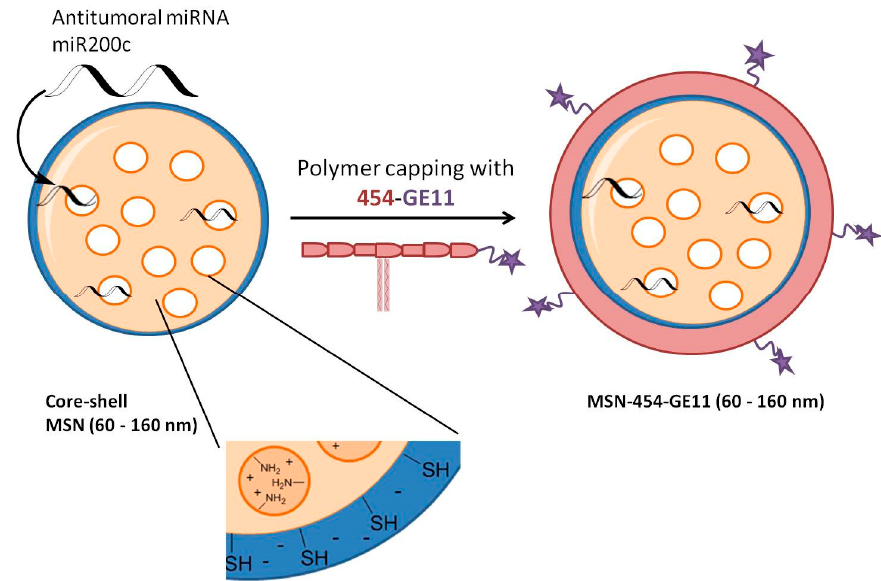
Figure 1. Schematic overview of the structure of core-shell mesoporous silica nanoparticles (MSN), the loading of miR200c and the polymer capping resulting in the MSN-454-GE11 vector. The